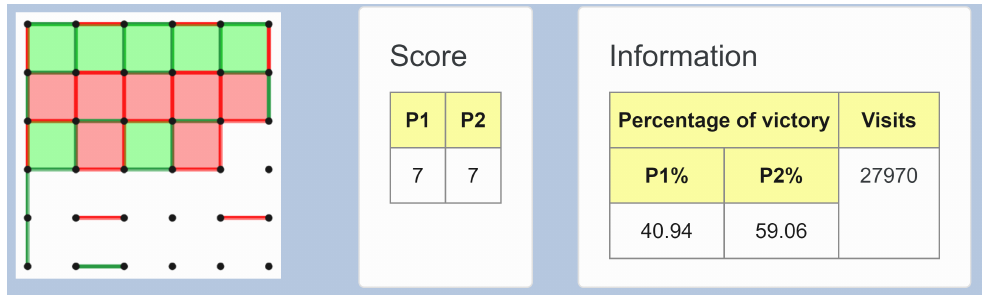
Figure 2. Tool tip displaying relevant information about a